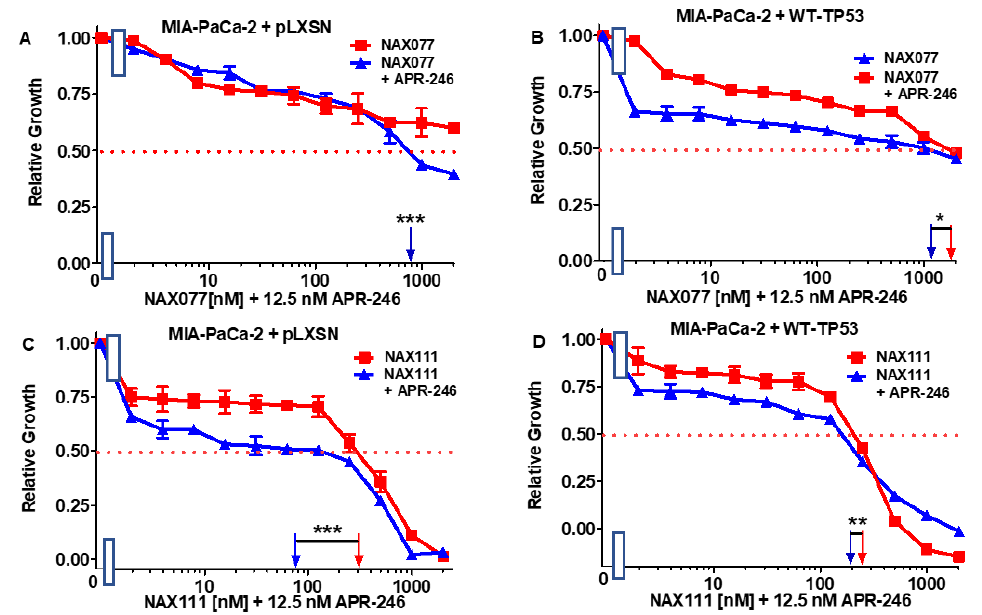
Figure 8. APR-246 has minimal effects on enhancing the effects of NAX077 and NAX111 in the presence and absence of WT-TP53. Panel ( A ) MIA-PaCa-2 + pLXSN cells treated with different concentrations of NAX075 (red squares) or with different concentrations of NAX075 and a low dose of APR-246 (blue triangles). Panel ( B ) MIA-PaCa-2 + WT-TP53 cells treated with different concentrations of NAX075 (red squares) or with different concentrations of NAX075 and a low dose of APR-246 (blue triangles). Panel ( C ) MIA-PaCa-2 + pLXSN cells treated with different concentration of NAX111 (red squares) or with different concentrations of NAX111 and a low dose of APR-246 (blue triangles). Panel ( D ) MI-PaCa-2 + WT-TP53 cells treated with different concentrations of NAX111 (red squares) or with different concentrations of NAX111 and a low dose of APR-246 (blue triangles). The measurements were repeated 4 times, and similar results were observed. *** = p < 0.0001, ** = p < 0.005, and * = p < 0.05.